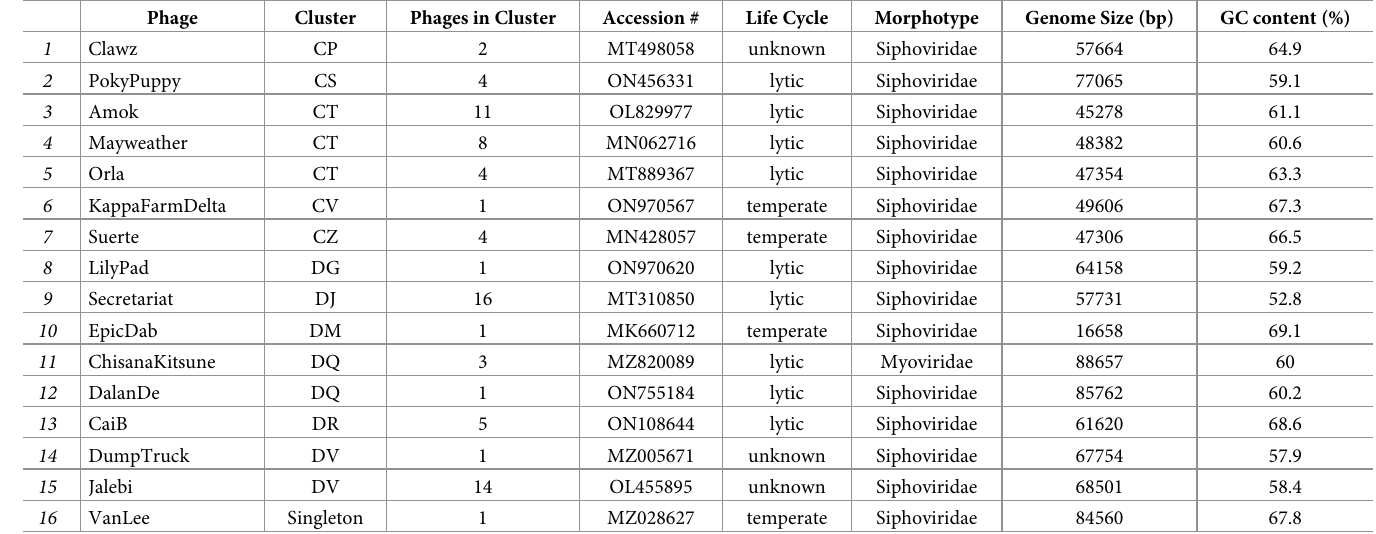
Table 1. Gordonia phages highlighted in this